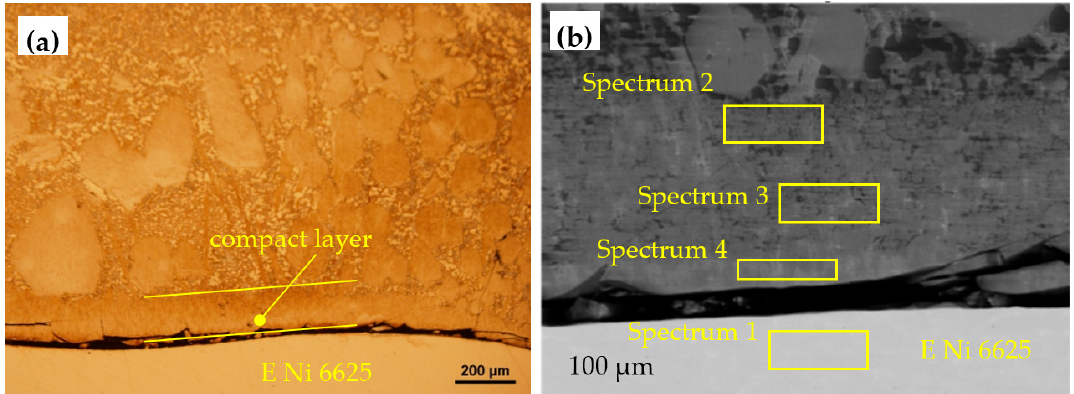
Figure 13. E Ni 6625 / 680 ◦ C / 120 min / AlSi9. Intermetallic compounds at the boundary between the